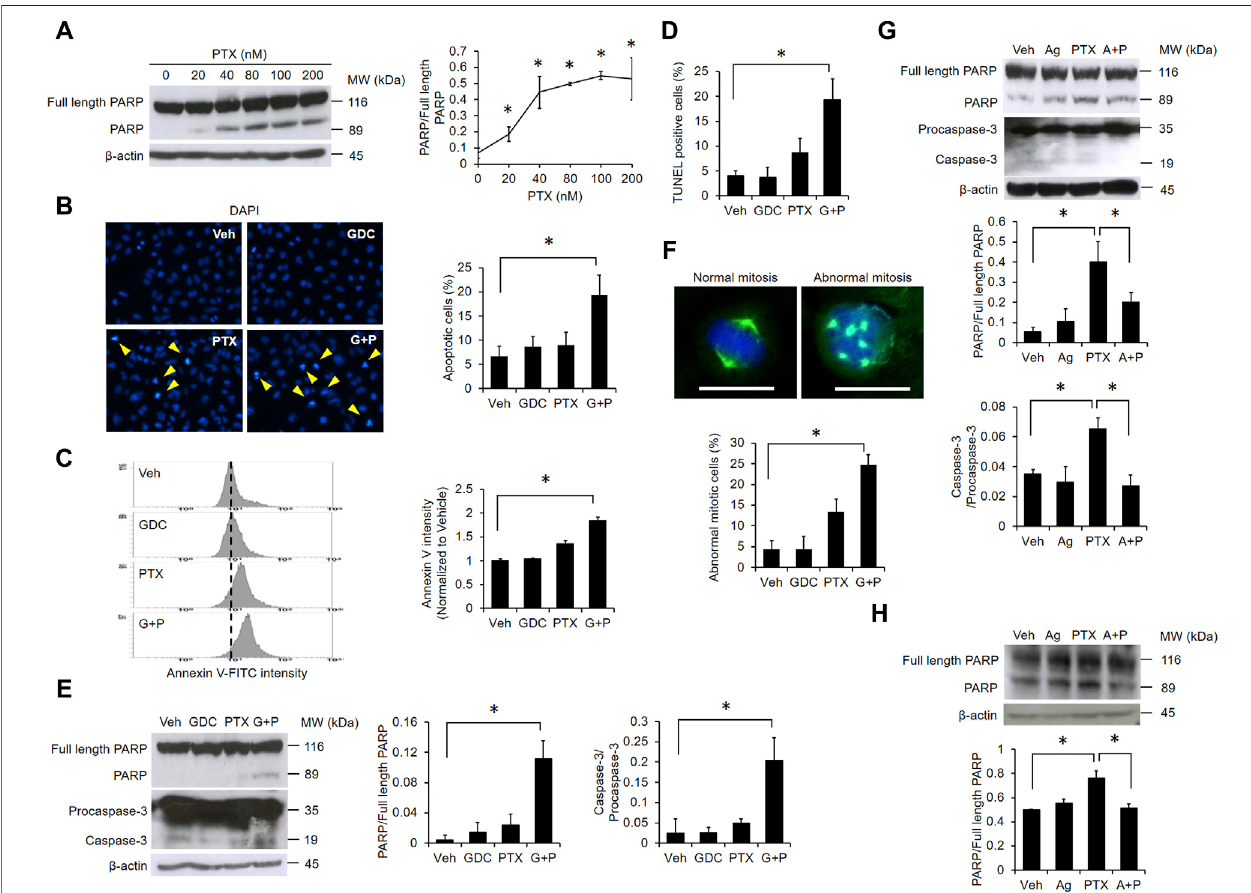
FIGURE 3 | GDC potentiates paclitaxel-induced apoptosis. (A) A549 cells were treated with indicated doses of PTX for 24 h. Whole cell lysates were immunoblottedwithanti-PARPandanti- β -actinantibodies.ProteinbandintensitieswereanalyzedusingImageJ.A549cellswerepreincubatedwithGDC(20 μ M)for1 h followedbyPTX(20 nM)treatmentfor24 h.Chromosomecondensationwasobservedunder fl uorescencemicroscopy (B) .Phosphatidylserineexposurewasassessed using annexin V-FITC staining by fl ow cytometry (C) . DNA double strand breaks were observed using TUNEL assay analyzed with fl uorescence microscopy (D) . Activation ofPARPand caspase-3 weremonitored bywestern blotting (E) .A549cells weretreated asin (B) ;cellmitosis wasobserved under fl uorescence microscopy. Greencolor:microtubule;bluecolor:cellnuclei.Scalebar:20 μ m (F) . (G) A549cellswerepreincubatedwithHh-Ag1.5(1 nM)for24 hfollowedbyPTX(20 nM)treatment for 24 h. Total cell lysates were immunoblotted with anti-PARP, anti-caspase-3, and anti- β -actin antibodies. Protein band intensities were analyzed using ImageJ. (H) H1299 cells were preincubated with Hh-Ag1.5 (1 nM) for 24 h followed by PTX (20 nM) treatment for 24 h. Total cell lysates were immunoblotted with anti-PARP and anti- β -actin antibodies. Protein band intensities were analyzed using ImageJ. *: p < .05; indicates a statistically signi fi cant difference between indicated groups. All experiments were performed at least three times. n = 3 for all groups.